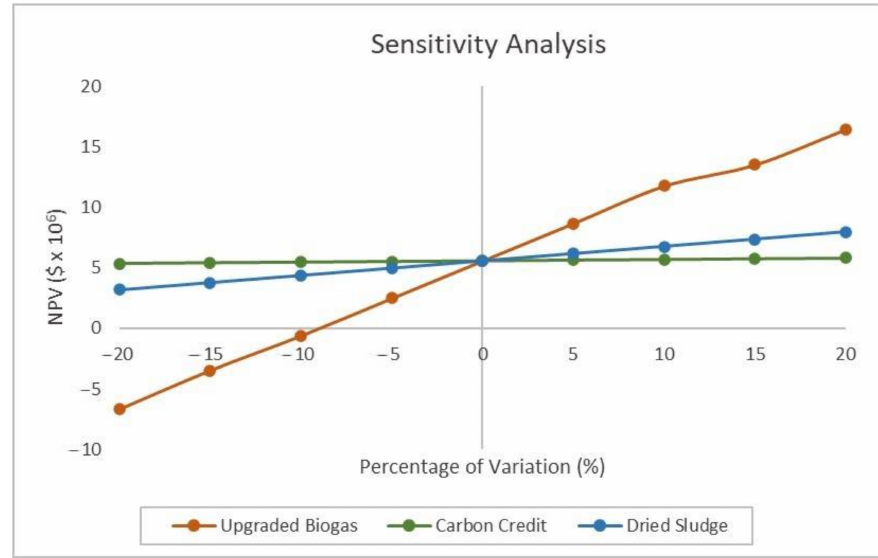
Figure 8. Sensitivity